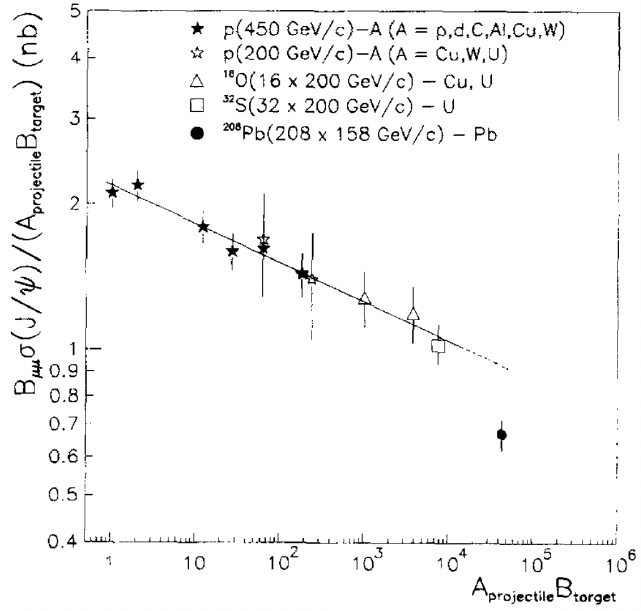
Figure 2. Observation of anomalous J / ψ suppression in nuclear–nuclear collisions at 158 GeV/c per nucleon by the NA50 Collaboration [6]. Reprinted with permission from